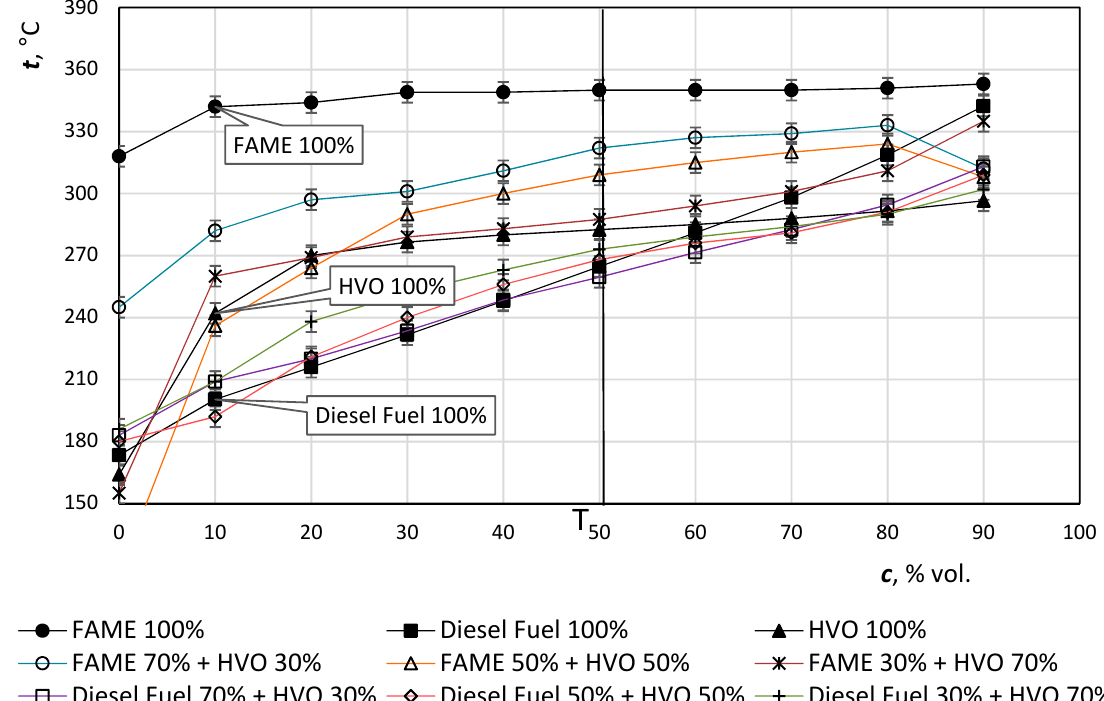
Figure 7. Distillation curves of FAME, diesel fuel, HVO and their mixtures.